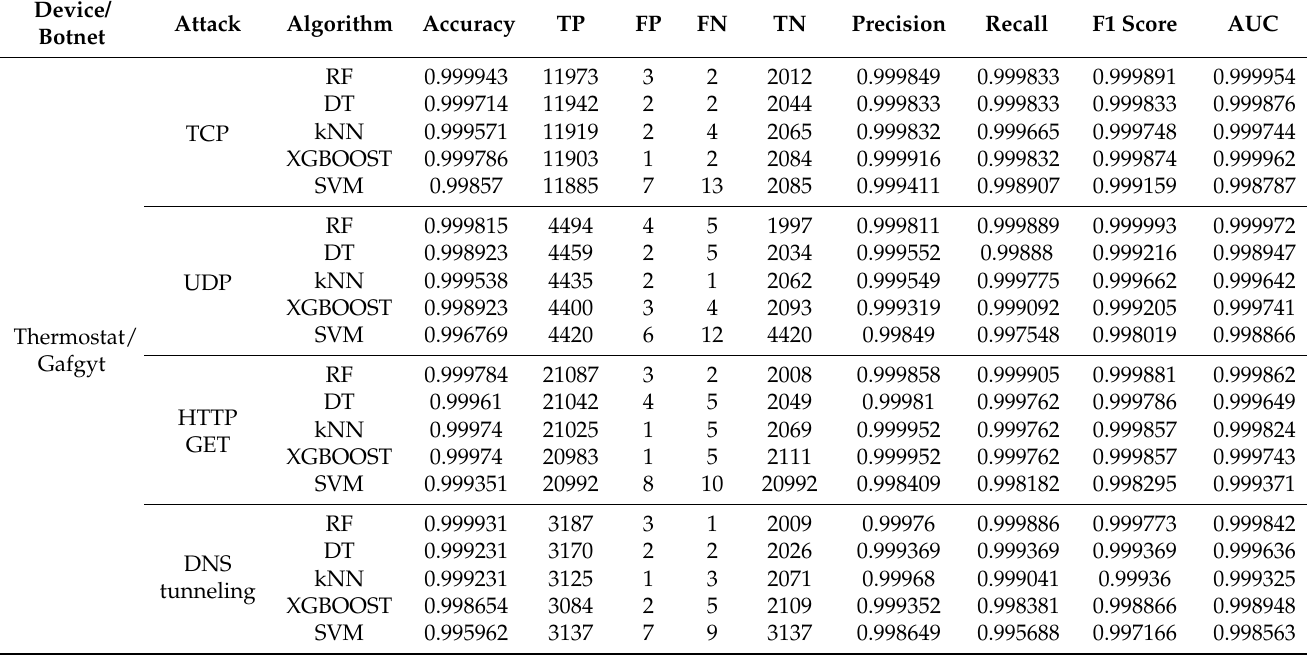
Table 15. Classification results